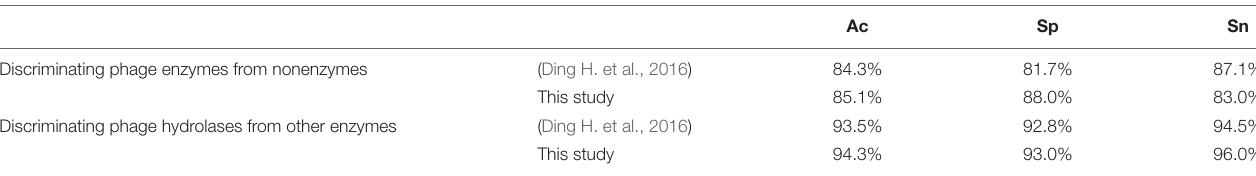
TABLE 5 | Comparison of predictive performance with exist